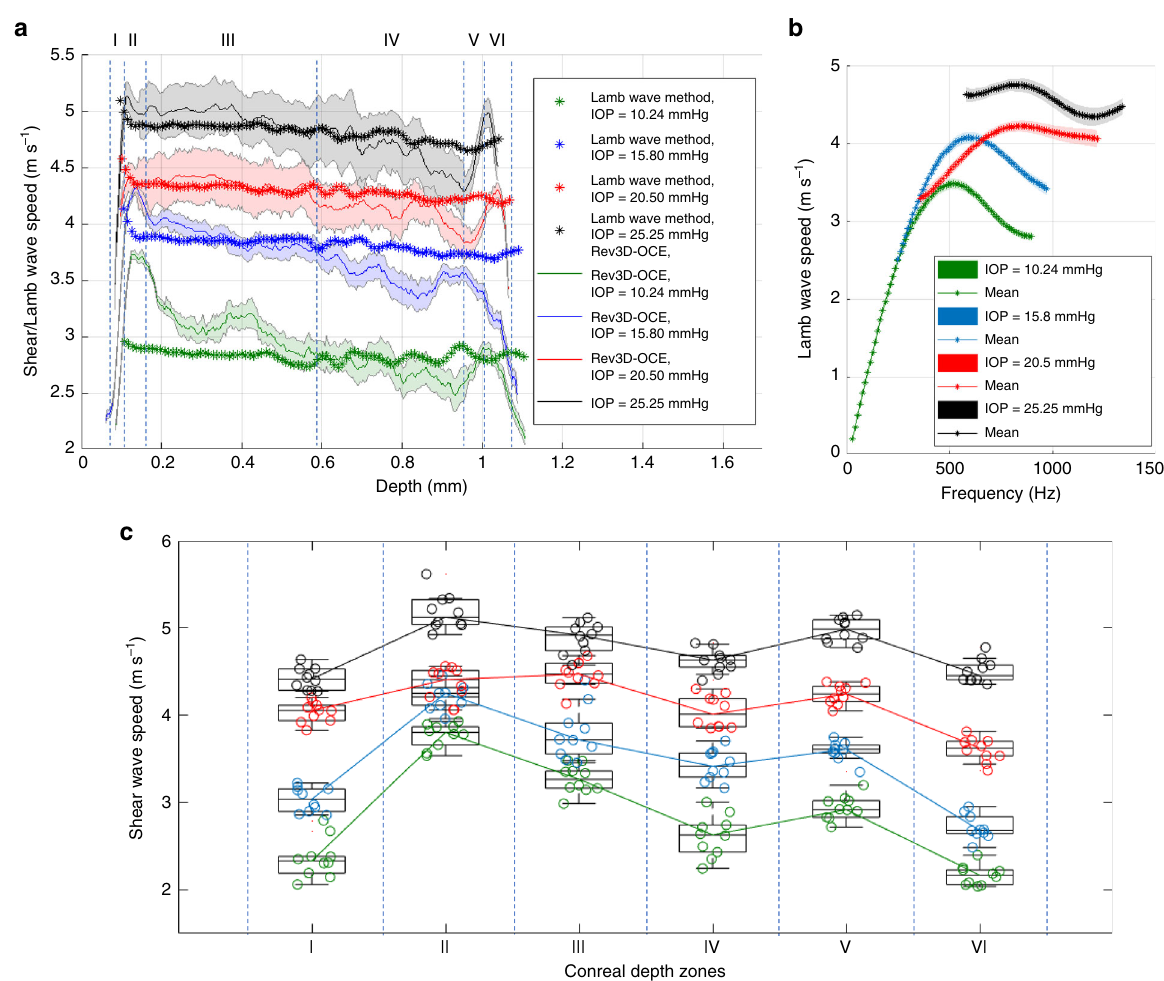
Fig. 6 Statistical analysis of depth-dependent wave speed pro fi les of ex vivo IOP-controlled porcine corneas. a Comparison of average depth-dependent wave speed pro fi les using Rev3D-OCE and the Lamb wave method in a single cornea subjected to four IOP levels: 10.24, 15.80, 20.50, and 25.25 mmHg. Mean± SE within every single layer. Lamb wave speed pro fi les were calculated at a frequency f 0 = 800 Hz to cover for all four IOP cases in ( b ). b Dispersion analysis of wave speed using the Lamb wave method in a cornea subjected to four IOP levels. Curves indicate that the antisymmetric zero- order Lamb wave is the most predominant given the excitation shape and boundary conditions. c Repeatability study ( N = 10 corneas) of depth-dependent shear wave speed pro fi les divided into six zones: I (epithelium), II (Bowman ’ s membrane), III (upper stroma), IV (lower stroma), V (Descemet ’ s membrane), and VI (endothelium), subjected to four IOP levels. Horizontal lines within boxes indicate median values, boxes denote interquartile ranges. Whiskers on the box plots span one standard